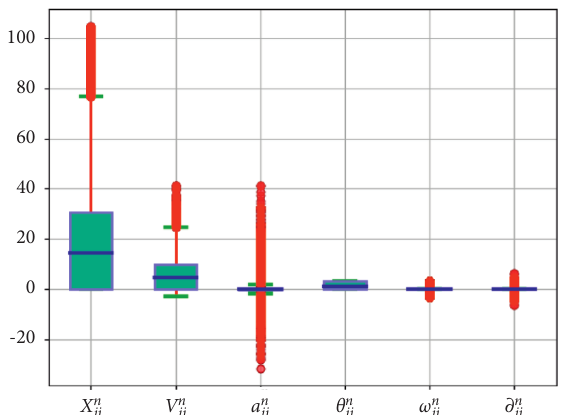
Figure 7: Box diagram of vehicle behavior in the closed curve section.